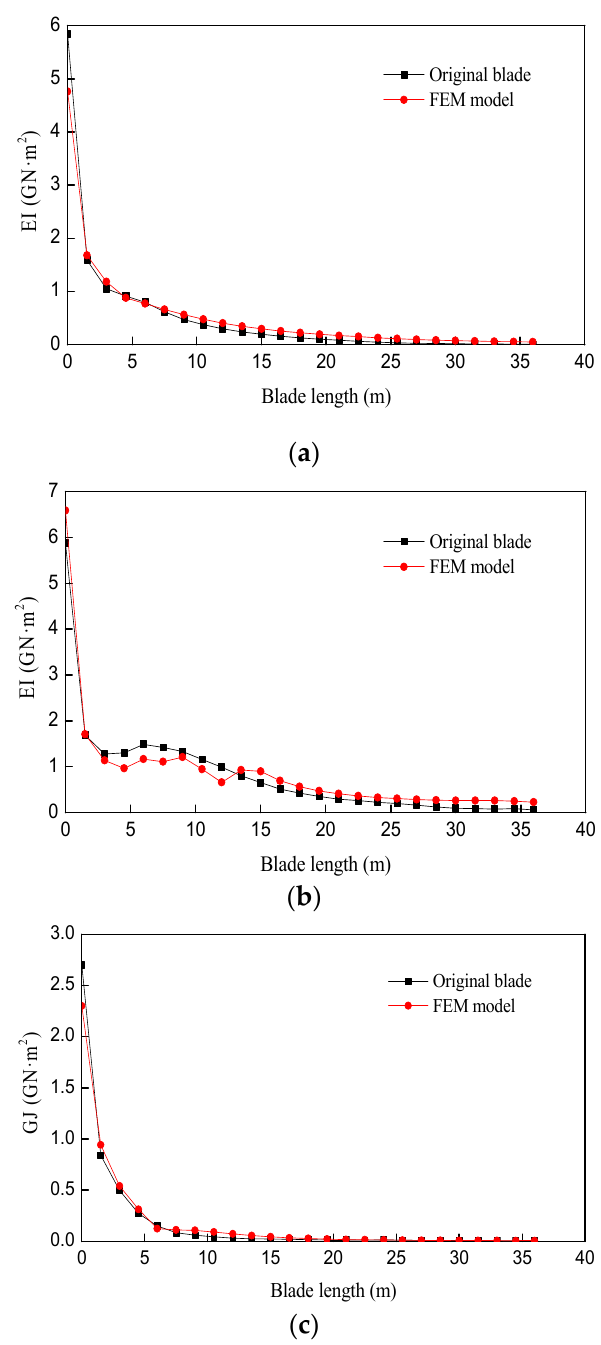
Figure 7. ( a ) comparison of the flap ‐ wise rigidity; ( b ) comparison of the edge ‐ wise rigidity; ( c ) comparison of the torsional rigidity.